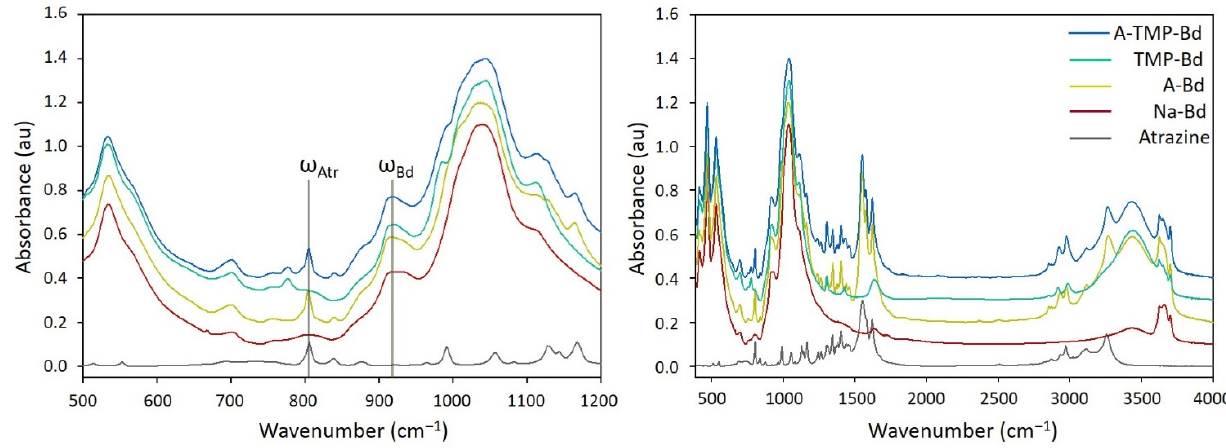
Figure 14. Comparison of the FTIR spectra for atrazine, pure beidellite (Na-Bd) and modified beidellite samples (A-Bd, TMP-Bd and A-TMP-Bd). For clarity, the spectra are consecutively shifted with respect to 0.0 au baseline and the spectrum of atrazine is scaled by a factor 0.3: (Left) spectra in the range 500–1200 cm − 1 ; and (right) complete spectra in the range 500–4000 cm − 1 .